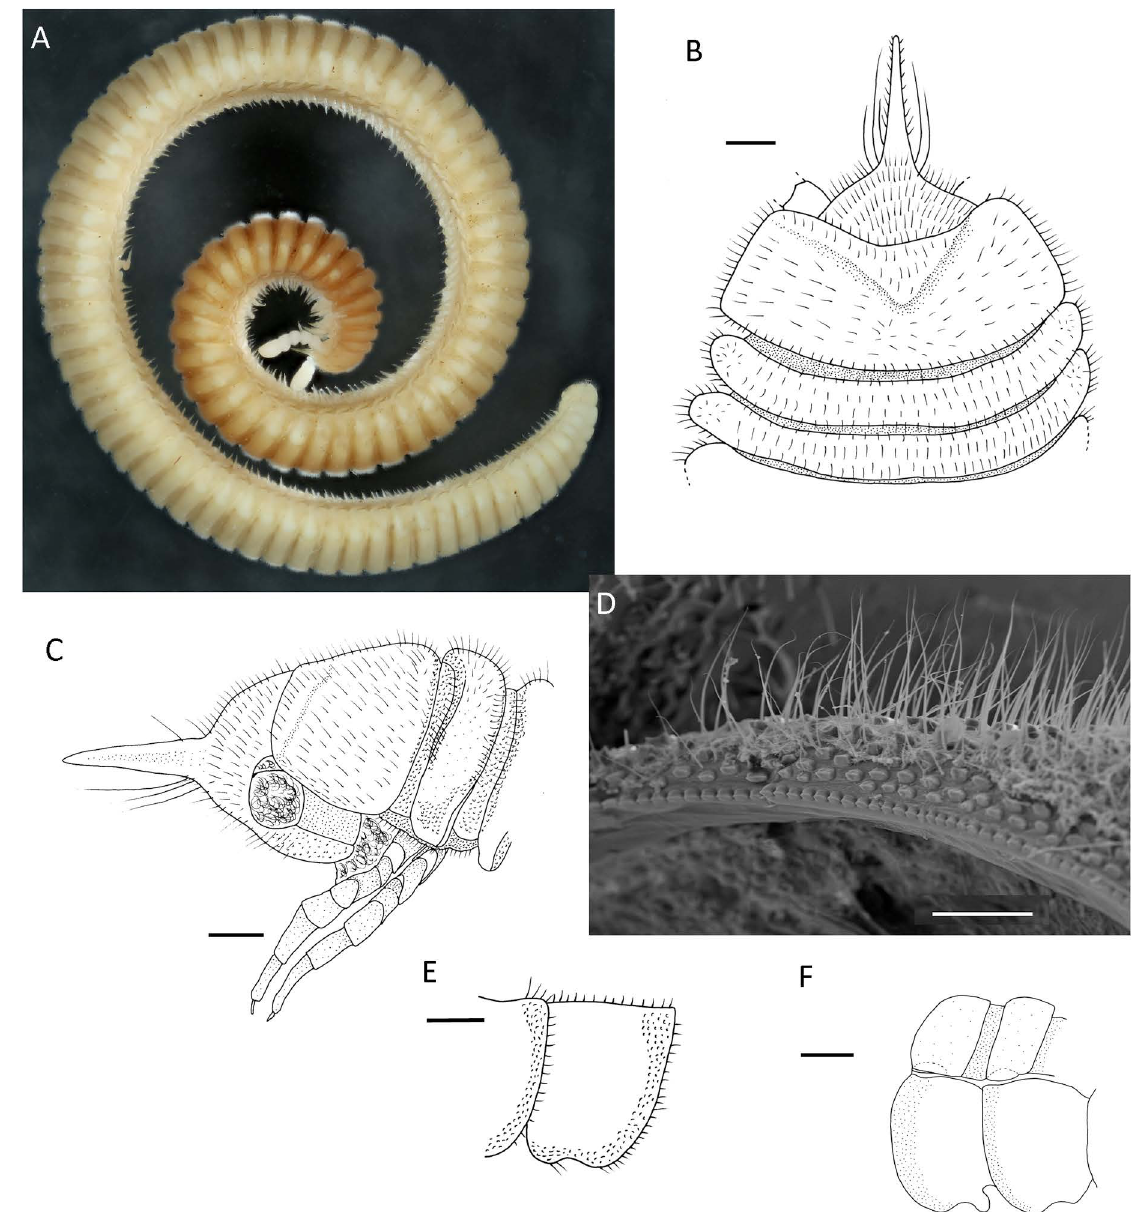
Fig. 2. Columbianum major sp. nov. A . Habitus of largest female paratype from Reserva Duche Terra Firme. Total length 43 mm. B–C , E–F . Holotype, ♂ . B . Head and anterior tergites in dorsal view. C . Head and anterior rings in lateral view. D . Paratype, ♂. Limbus of midbody metazonite of male in posterior view. E . Pleurites in lateral view, midbody rings (anterior to left). F . Pleurites in lateral view, rings 6 and 7 (anterior to left). Scale bars = B–C, E–F = 0.2 mm; D = 0.1